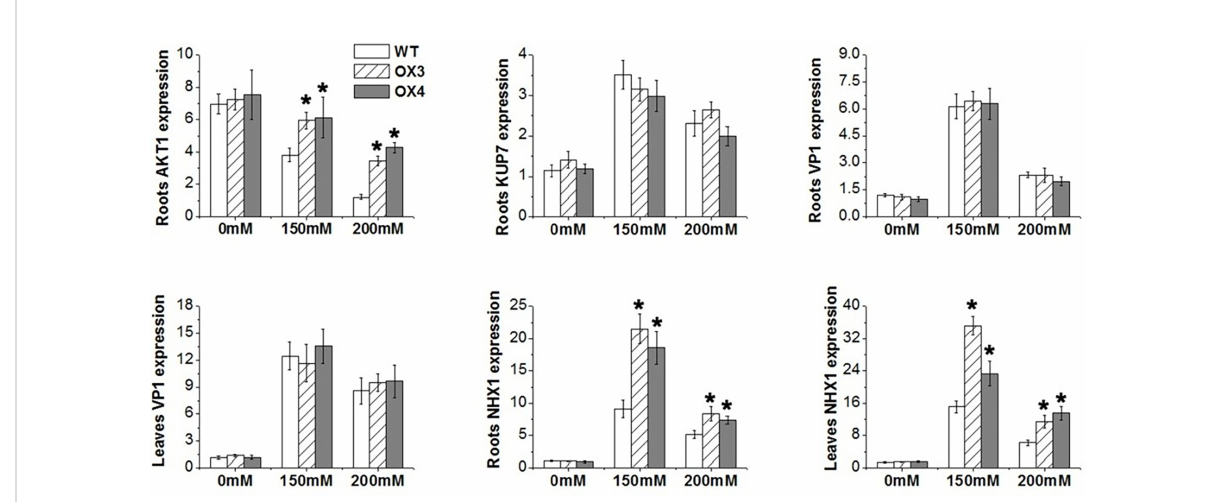
FIGURE 9 The relative expression of genes regulating ions balance in Arabidopsis under salt stress. ZmGnTL -OX plants and WT were treated with 0 mM, 150 mM, and 200 mM NaCl for 48 h. Data are shown as means ± SE of fi ve biological replicates, and * indicated statistical signi fi cance at *P<